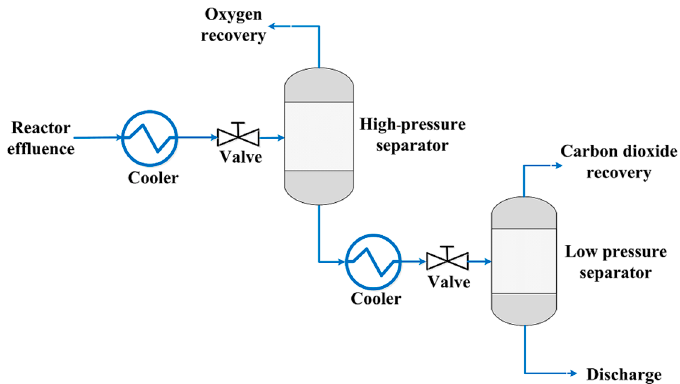
Figure 4. The simulation flow of the high-pressure water absorption for oxygen recovery.